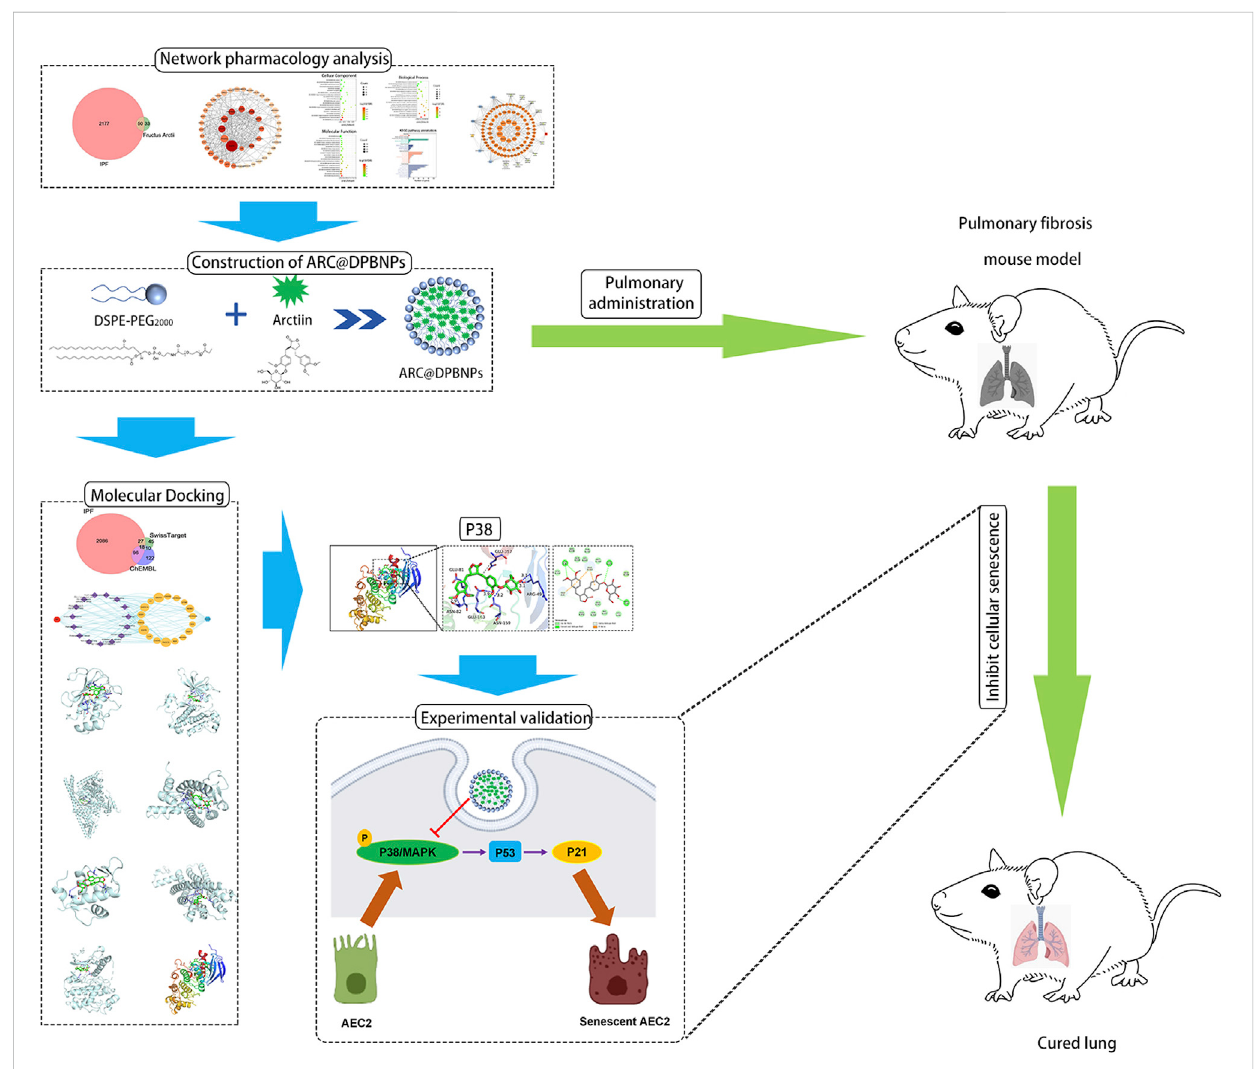
FIGURE 11 The work fl ow to identify the proposed mechanism showing that arctiin (ARC)-encapsulated DSPE-PEG bubble-like nanoparticles (ARC@DPBNPs) inhibit senescence of AEC2 to alleviate pulmonary fi brosis via the p38/p53/p21